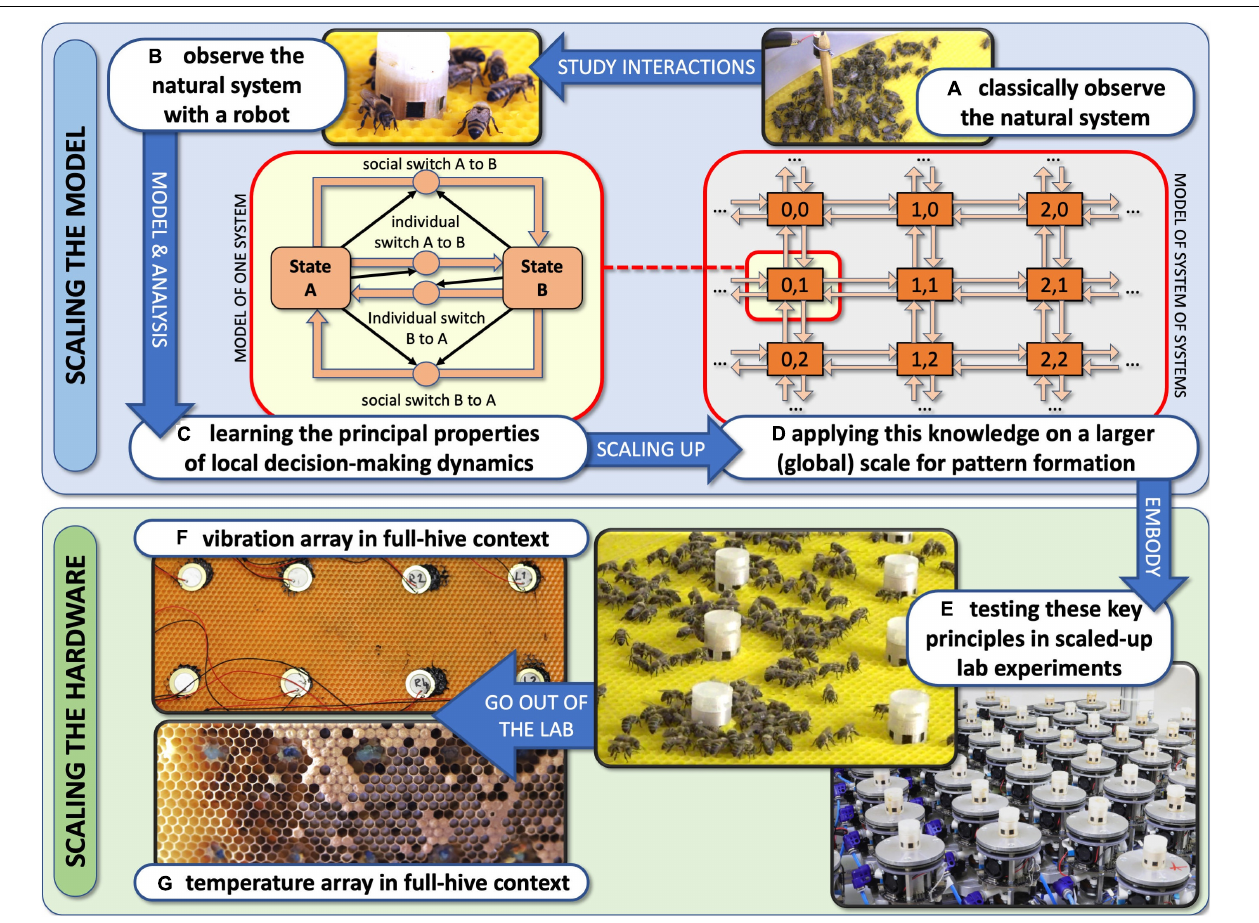
FIGURE 14 | Summary of the work process that we suggest for developing ecologically relevant autonomous robotics. (A) Observing the interaction patterns of organisms. (B) Studying their reactions to stimuli emitted by robots and also the robot’s sensing capabilities for relevant environmental configurations. (C) Describing these interactions in small-scale specific models to identify relevant core principles that can be used for larger-scale pattern formation. (D) Scaling these models up to larger, thus more relevant, sizes. (E) Testing scaled-up pattern formation in specific hardware equipment under laboratory conditions in order to test the validity of the scaled models. Finally applying the behavioural modulation on the targeted size- and time-range (in our case a full honeybee comb over weeks or months) to employ specific stimulus patterns to be used to interact with the target organism population, e.g., comb vibration (F) or temperature distributions (G)